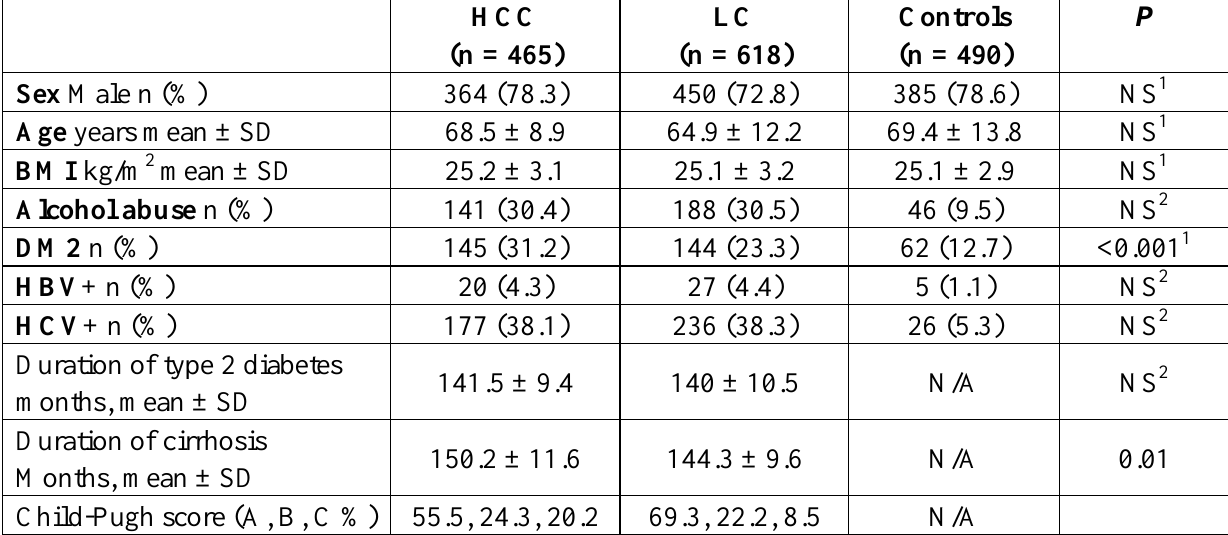
Table 1. Characteristics of the HCC, LC and Control